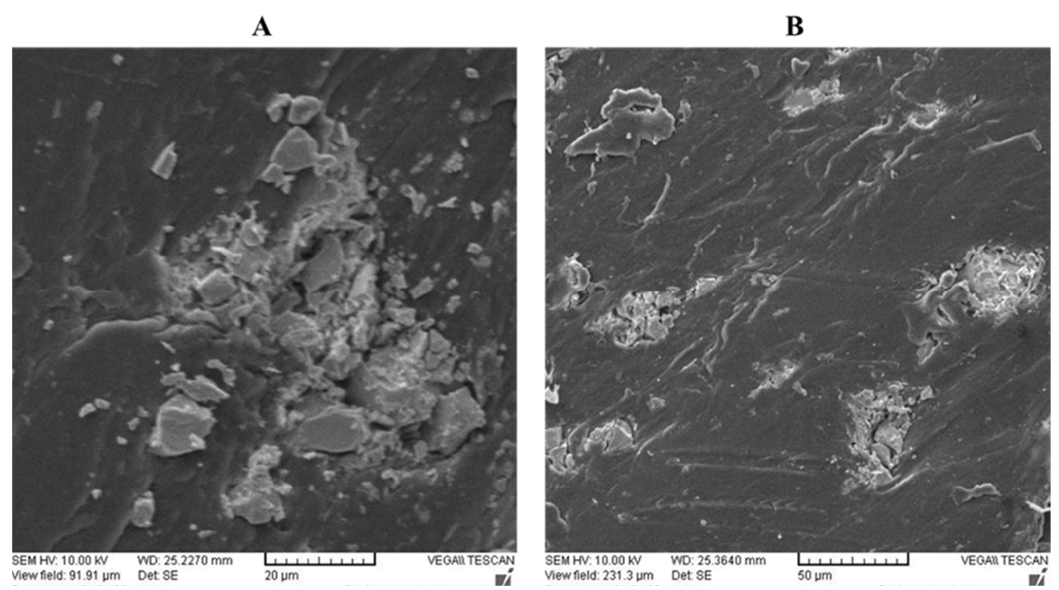
Figure 4. The SEM pictures were taken on PP/PRIEX/10 SAO 1 ( A ) and PP/PRIEX/10SAO 2 ( B ) .